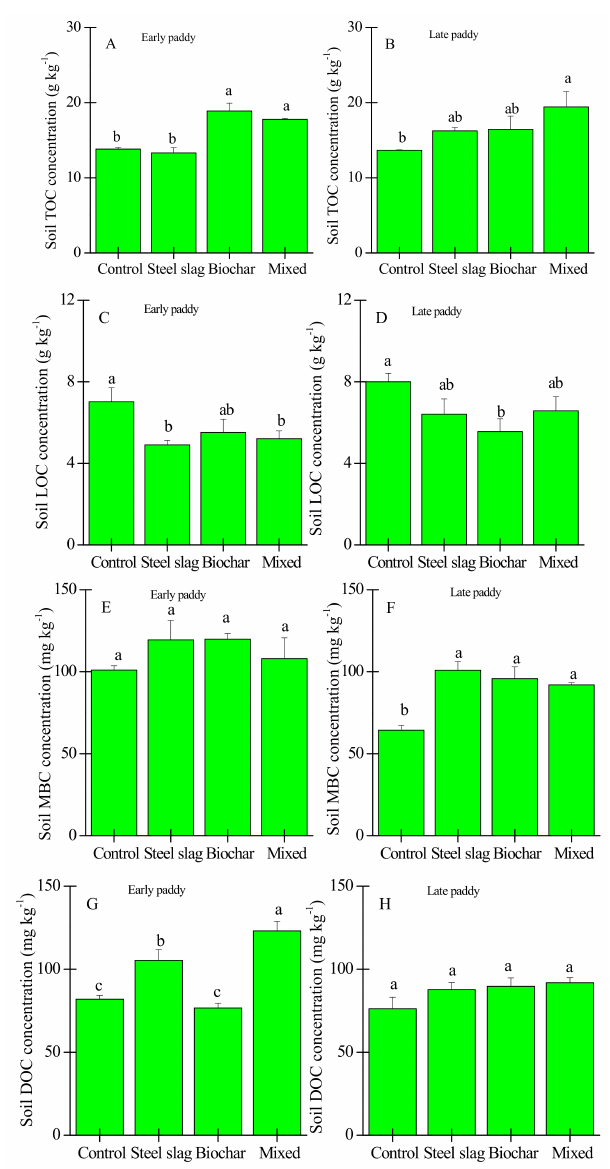
Figure 2. Mean concentrations of SOC ( A , B ), LOC ( C , D ), MBC ( E , F ), and DOC ( G , H ) in the treatment and control plots in the early and late paddy fields. Different letters represent significant difference in mean values among treatments ( p < 0.05, n =